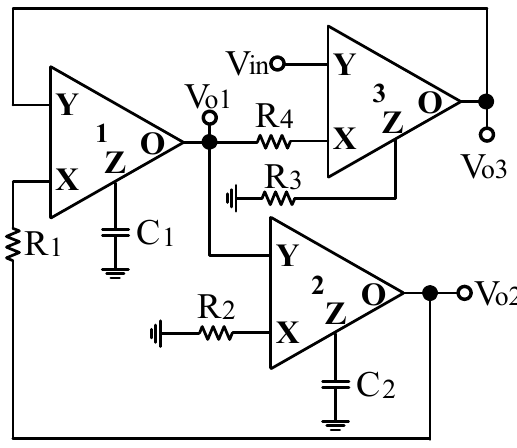
Figure 2. Proposed VM multifunction biquad filter.